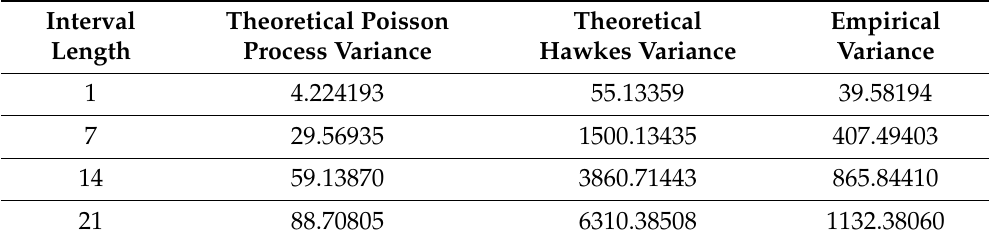
Table 3. Comparison of Theoretical Variance of Poisson Process and Hawkes Process vs. Empirical Variance for Different Interval Length Time in Days of Group 1.